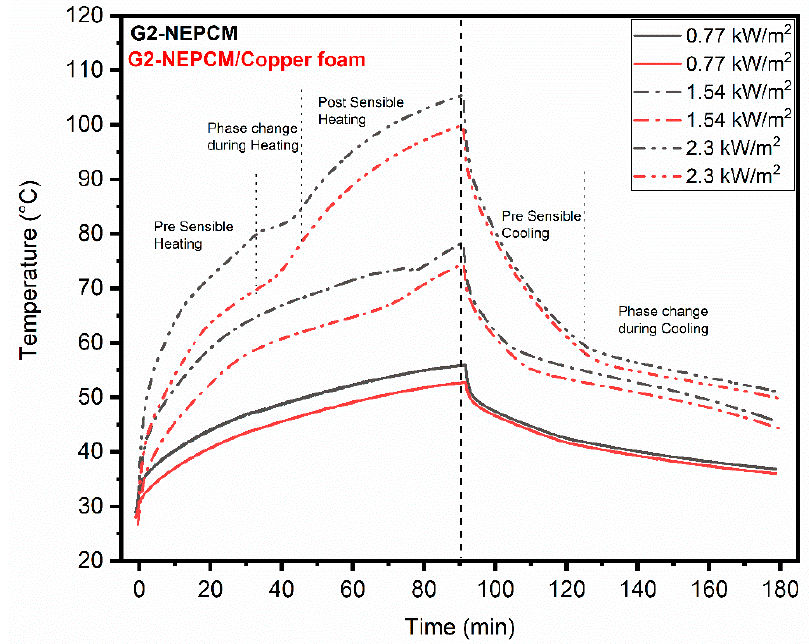
Figure 17. Charging and discharging curves for G2-NEPCM and G2-NEPCM/copper foam at different heating inputs.